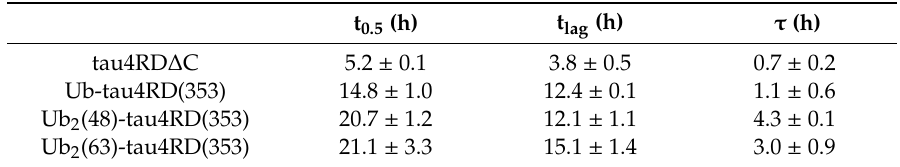
Table 1. Kinetic parameters for the aggregation of tau protein samples, determined on the basis of ThT fluorescence assays. 1